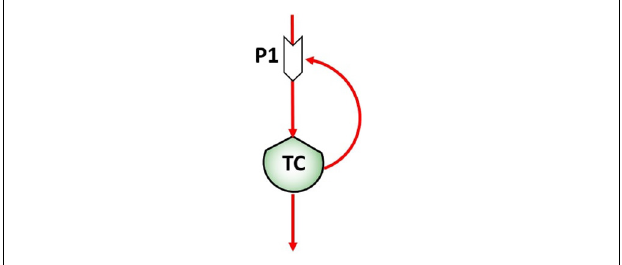
FIGURE 2 | Reinforcing feedback of the tumor cells stock (TC) on the birth process (P1), giving rise to the proliferation.